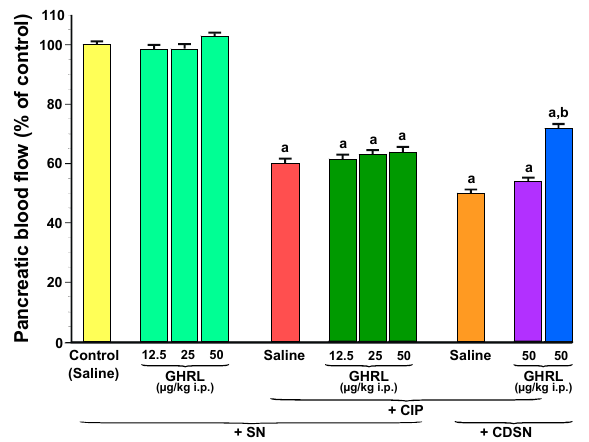
Figure 5. Effect of saline or ghrelin (GHRL) given intraperitoneally at a dose of 12.5, 25 or 50 μ g/kg and cerulein-induced pancreatitis (CIP) on pancreatic blood flow in sensory nerves-intact rats (SN) or rats with capsaicin deactivation of sensory nerves (CDSN). a p < 0.05 compared to the control group with intact sensory nerves and without induction of CIP; b p < 0.05 compared to sensory nerves-intact rats pretreated with GHRL at a dose of 50 μ g/kg without induction of CIP. Mean ± SEM from values obtained from 10–15 rats in each experimental group.